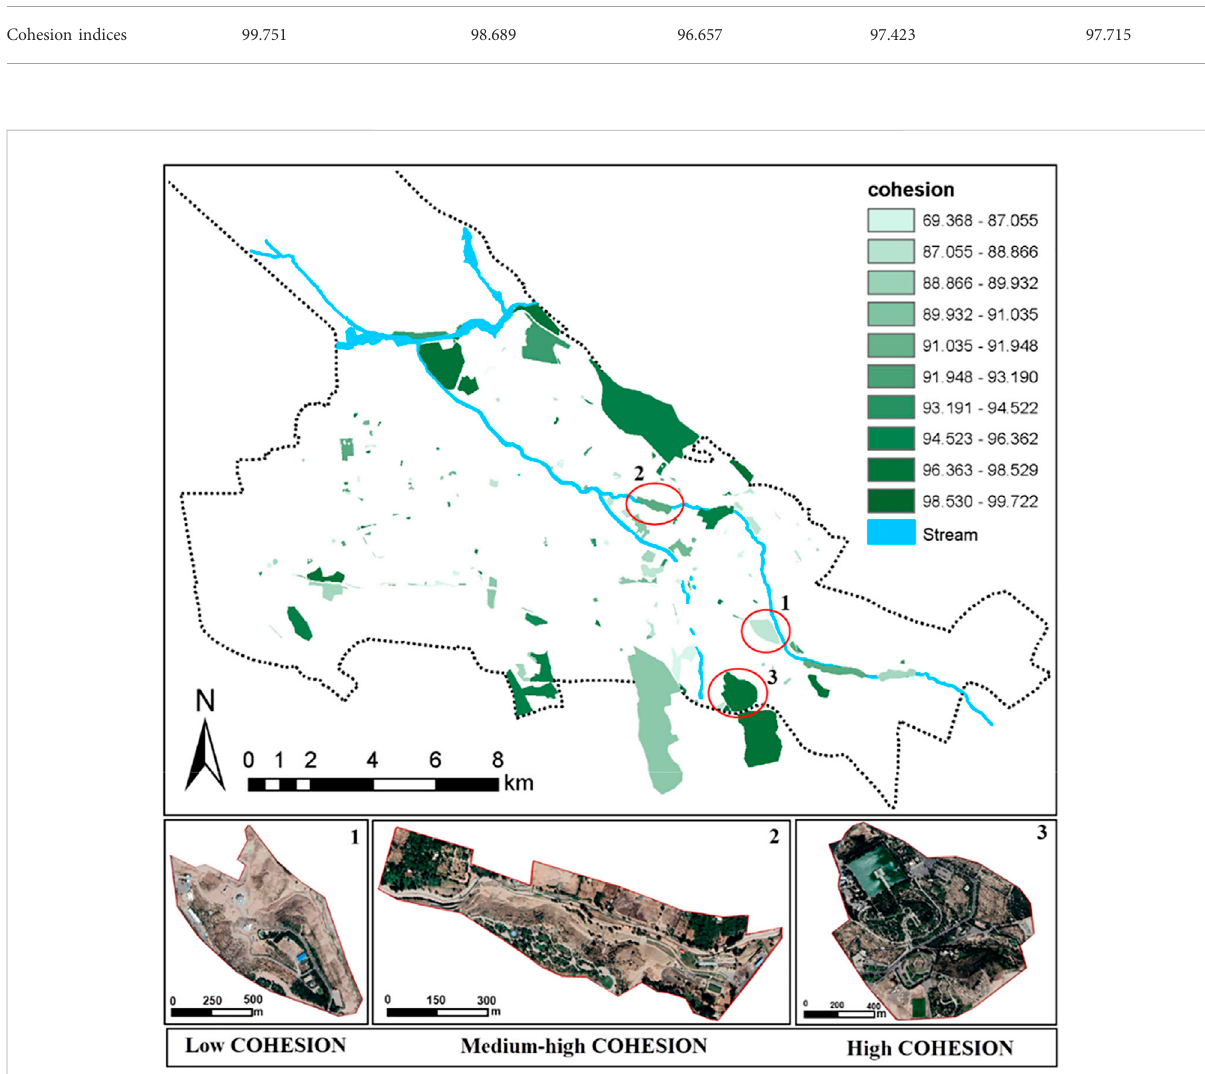
FIGURE 4 The Cohesion index values for the green spaces of the Tabriz metropolis at the level of classes (Darker patches have high connectivity and brighter have less